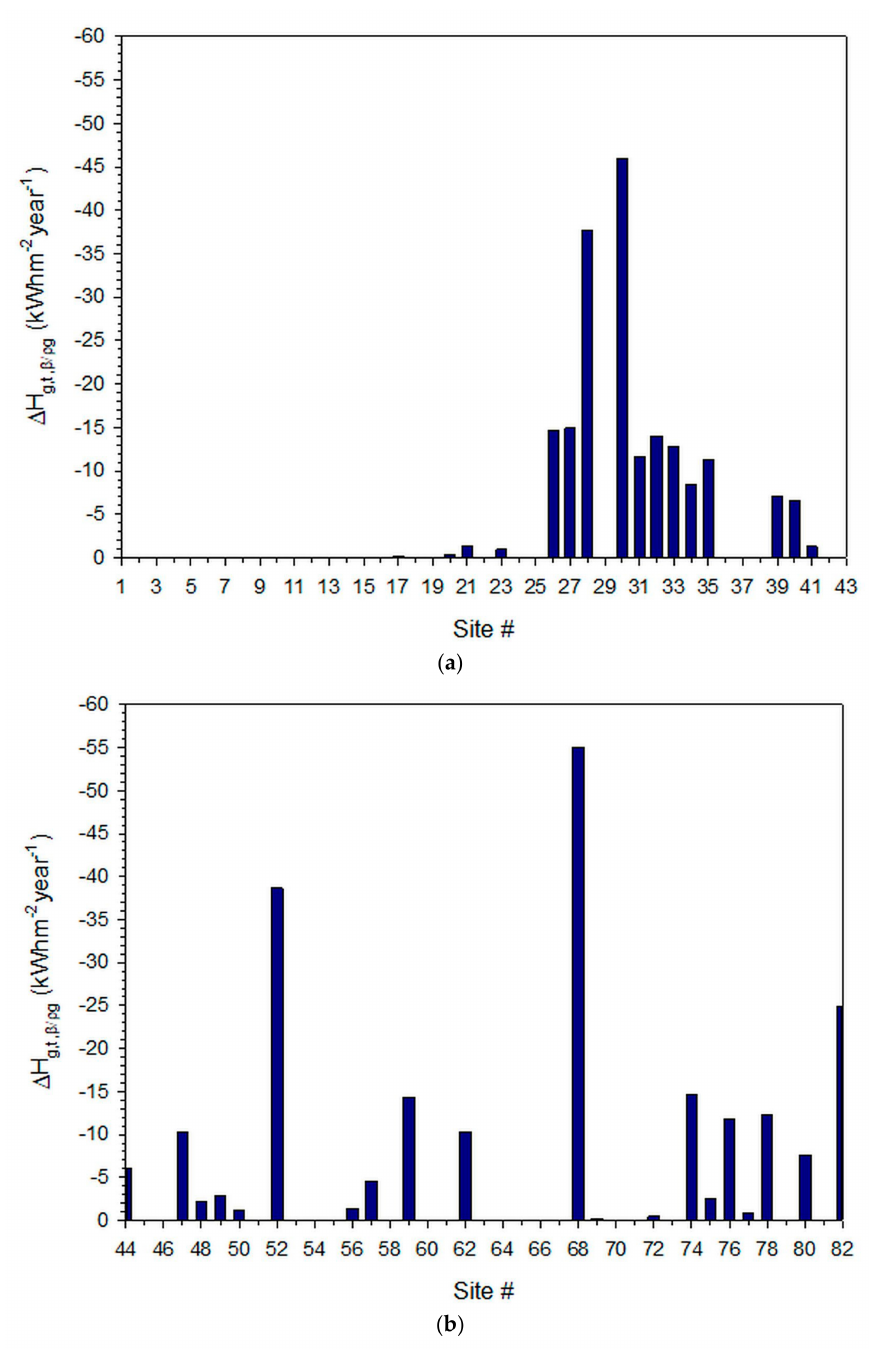
Figure 4. Differences of the annual maximum solar energy sums, ∆ H g,t, β / ρ g , on flat planes between optimally-derived and selected tilt angles for sites ( a ) 1–43 and ( b ) 44–82, under all-sky conditions and averaged over the period 2005–2016. ∆ H − H g,t, β / ρ g = H g,t,opt. β / ρ g g,t,selected opt. β / ρ g , where t refers to the tracking mode. The individual H g,t, β / ρ g values in the differences are shown in Table 2 (columns 3 and 4, respectively) together with their optimal β